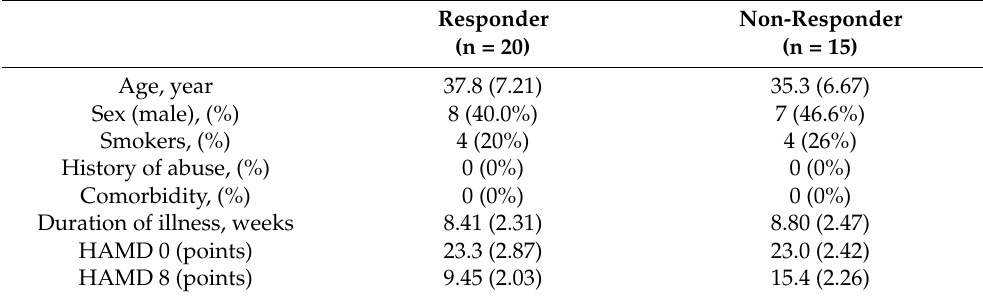
Table 1. Background of treatment response group and treatment cost response group.